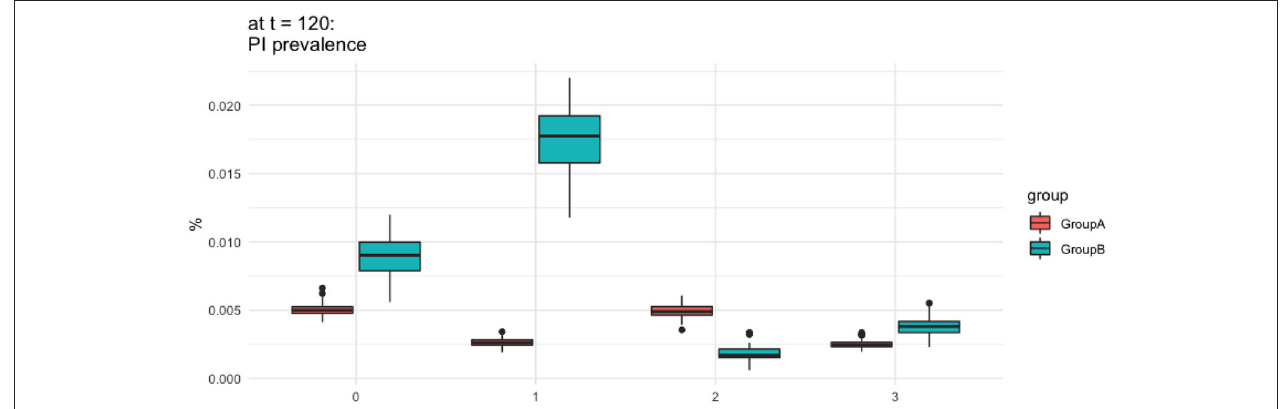
FIGURE 7 | Prevalence of persistently infected animals. The y -axis presents the percentage of animals that are PI form the total cattle population in each scenario. Scenario 0 represent baseline scenario. This plot aims to compare the prevalence of PI in each type of scenario in each group at the end of simulation time (t =